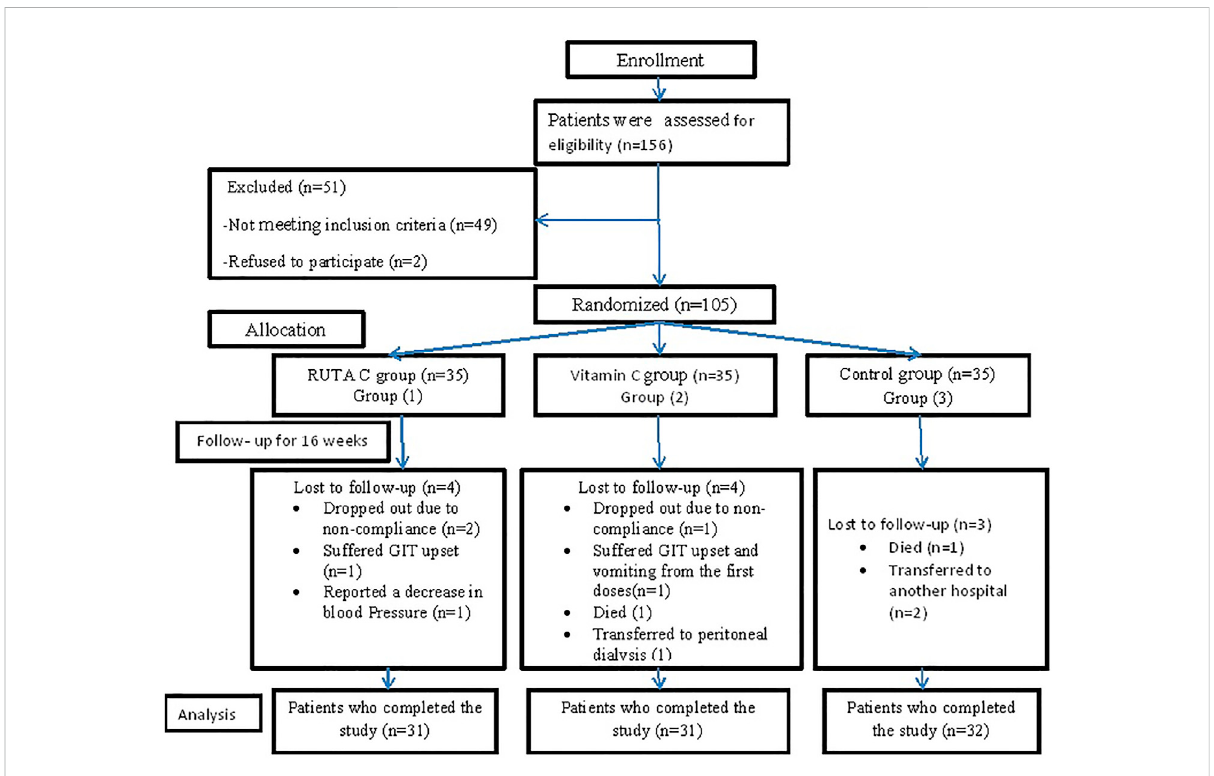
FIGURE 1 Flow diagram representing enrollment, allocation, follow-up, and analysis